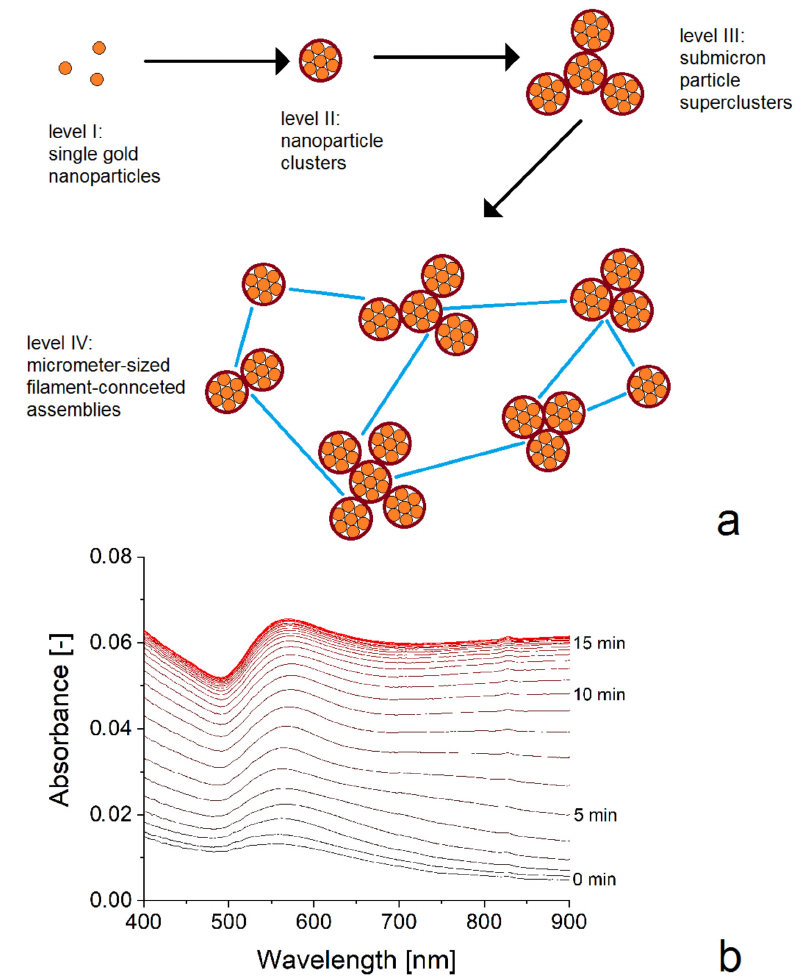
Figure 6. Evolution of particle formation and assembly: ( a ) illustration of structural hierarchy in the formation and assembly of gold nanoparticles during their formation by the reduction of HAuCl 4 with ascorbic acid; ( b ) example of temporal evolution reflecting the formation of single particles in the beginning (first measurement cycles) and later increasing long-wavelength absorption indicating the formation of particle clusters. The effect of poly-DADMAC is not limited to causing particle attachment. In addition, the application of these polycationic molecules influences the particle nucleation and growth. The addition of a final concentration of 100 ppm poly-DADMAC leads to a signif- icant reduction in the formation rate of small spherical or compact nanoparticles with the characteristic resonance at about 550 nm (Figure 7a) and to a significant enhancement of absorption in the NIR range (Figure 7b). In experiments with a reduced concentration of ascorbic acid of 60 µM and 70 µM HAuCl4, this long-wavelength absorption is related to the formation of nonspherical gold nanoparticles with higher aspect ratios (Figure 8a–d). In addition, it is remarkable that the increase of 550 nm absorption in the presence of poly-DADMAC occurs approximately linearly, which indicates a slow and nearly constant